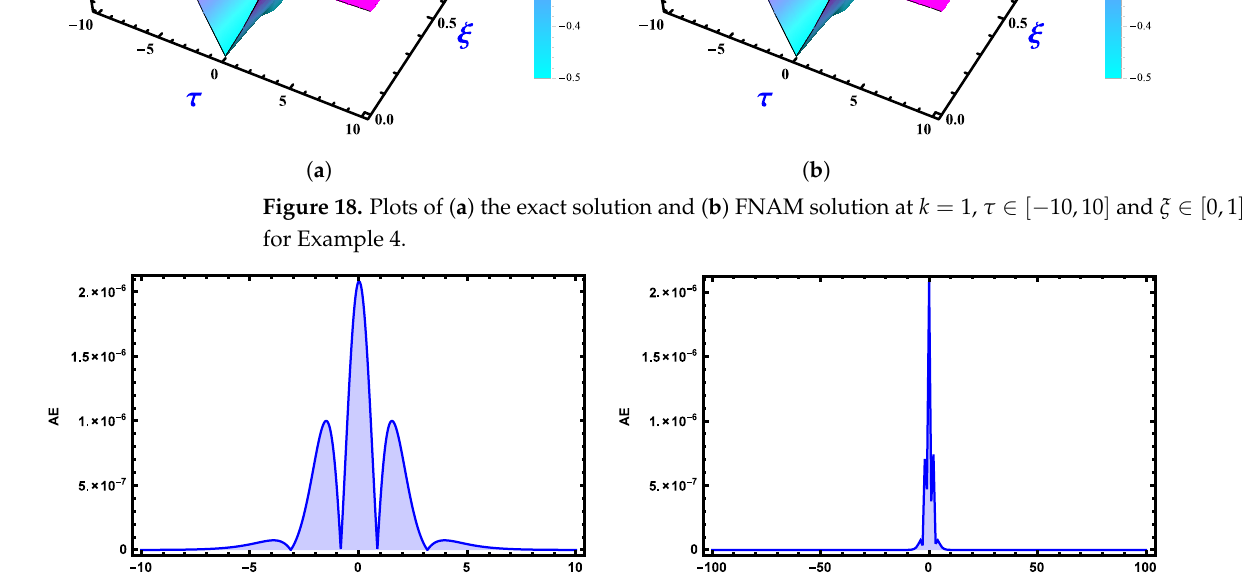
Figure 19. Absolute Error (AE) 2D graphs of obtained numerical solutions by using FNAM